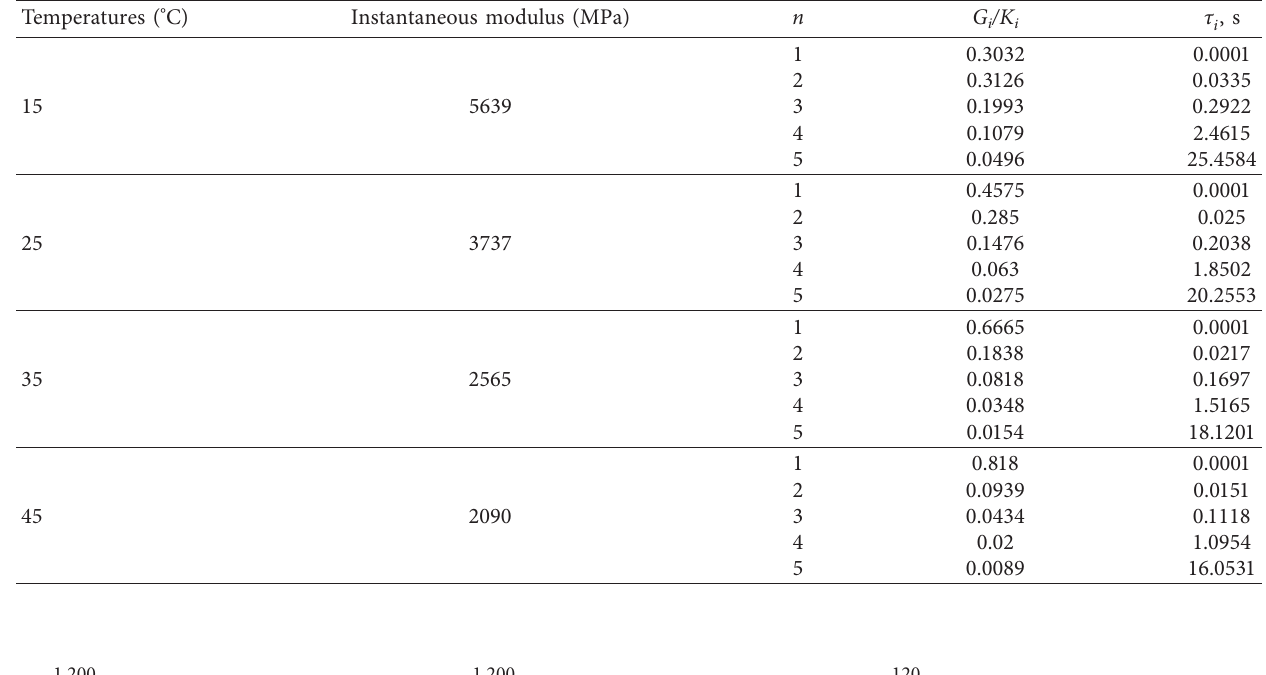
Table 12: Viscoelastic parameters of the asphalt mixture at different temperatures.